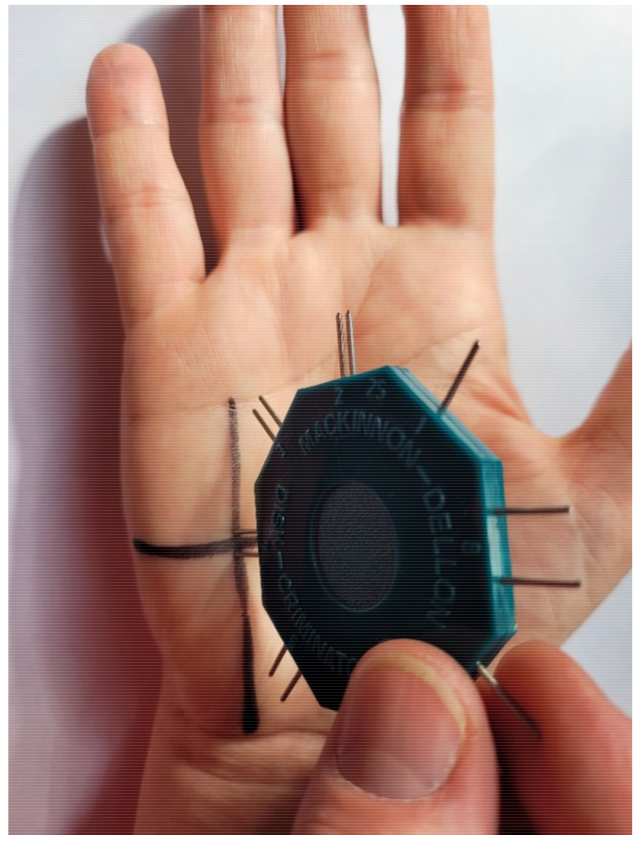
Figure 3. Methodology of testing